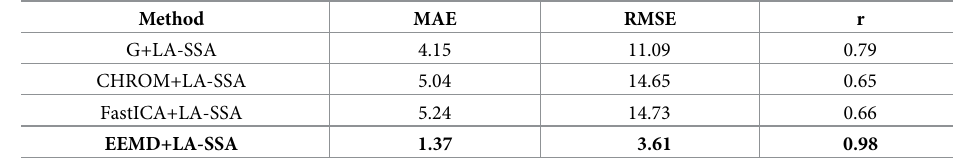
Table 3. Performance comparison of LA-SSA HR estimation using different input signals.